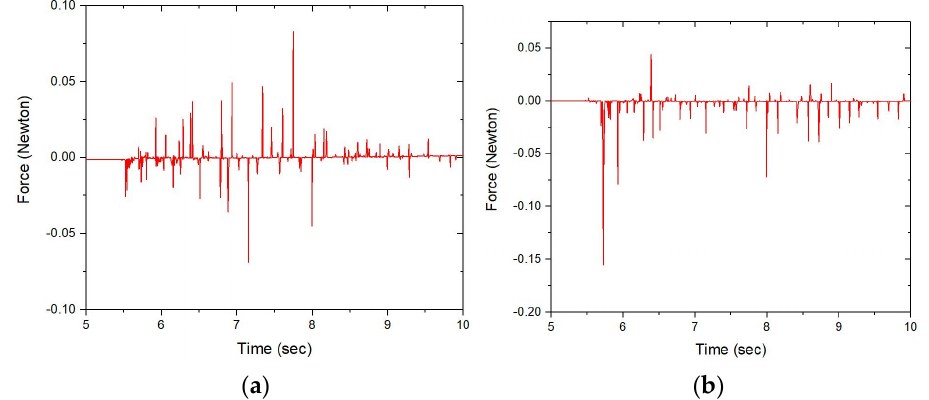
Figure 19. The force along the y − axis and the z − axis at the connection point of the robot, with a 400 mm turning radius: ( a ) 400 mm z − axis force; ( b ) 400 mm y − axis force. After comparing the results of the three sets of simulations, the force changes at the pipeline robot connection point were seen to be small and approximately the same. It indicates that the change in the turning radius over the minimum critical value has little effect on the force of the coupling. According to the above figure, Figure 19a shows the force on the connection point along the z − axis when the robot was cornering, and it was also the tangential force along the pipe section. The positive direction of the z − axis is the pulling force along the outside of the pipe. Conversely, it is the thrust along the inner pair of the pipe. As shown in the figure, the two forces in the z − axis direction were relatively uniform and cancelled each other out during the turning process. During the rotation, the coupling reciprocates inward and then outward, and the force increases and then decreases. It means that the angle of motion increases first and then decreases. The swing angle of the coupling is the largest in the turning transition section. Figure 19b shows the force on the connection point along the y − axis when the robot was cornering, which was also the normal force along the pipe section. The positive direction of the y − axis was the reverse friction force of the cup during operation. In the opposite direction, the drag force is generated under the influence of the rear pressure. As shown in the figure, the friction force always existed during the operation, and the friction force changed greatly at the moment of entering and exiting the bend pipeline. However, during the motion, the drag force of the robot is much greater than the friction force of the leather bowl. This ensured that the pipeline robot successfully completed the pigging task with minimal damage to the robot. Ensuring that the initial force of the pipeline robot remained unchanged, the speed fluctuation and vibration effect of the pipeline robot under the three groups of different turning radii were analyzed. Ensuring that the elastic contact between the leather bowl and the tube wall, the friction coefficient and the recovery coefficient were unchanged, and the same pressure was passed into the entrance. The simulation results are shown in Figures 20 and 21.